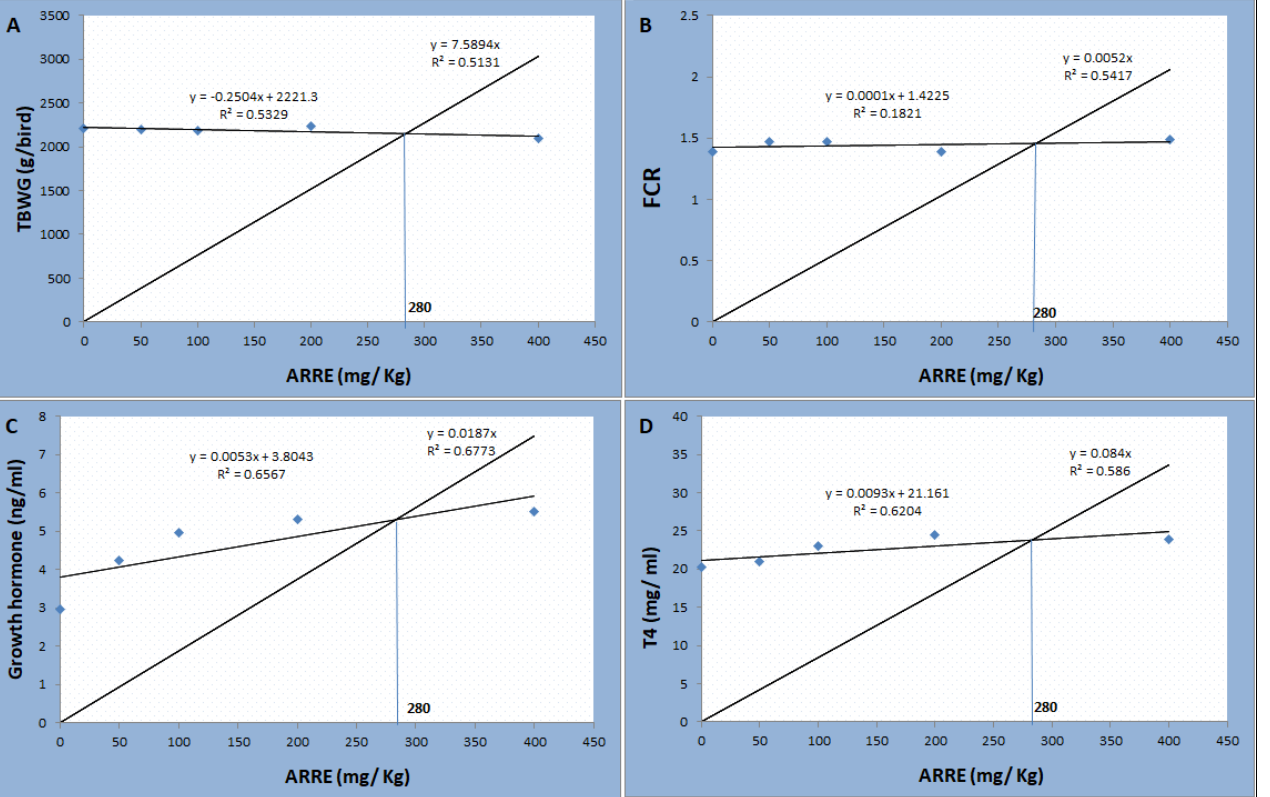
Figure 4. The broken-line regression model shows the optimum dietary level of ARRE addition based on the data of TBWG ( A ), FCR ( B ), growth hormone ( C ), and T4 ( D ).